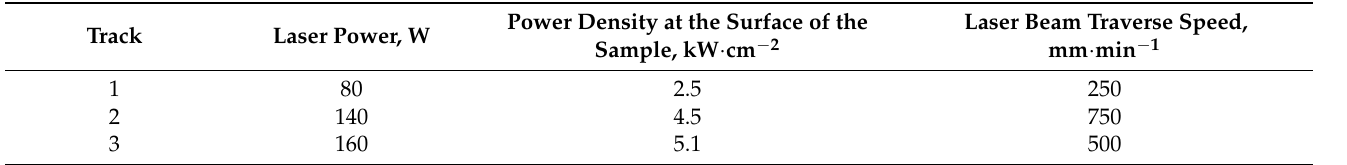
Table 4. Parameters of the laser surface-heating process for the tracks selected for hardness and MBN measurements and microstructure examination.